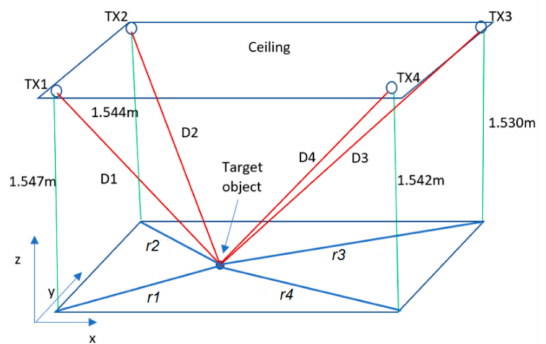
Figure 1. Horizontal (projected) distance range values, r1, r2, r3 and r4 on the XY